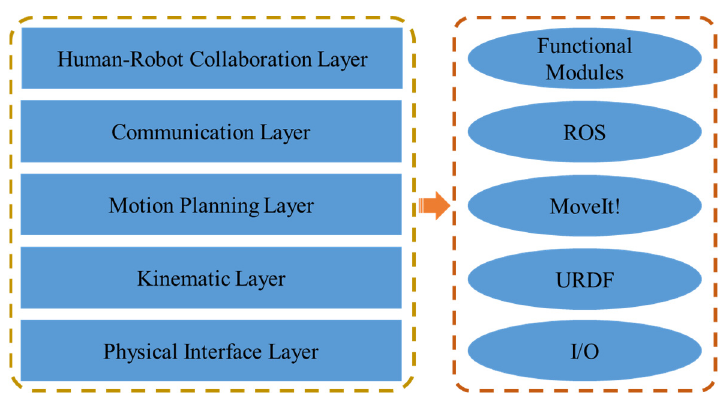
Figure 5. The structure of the control